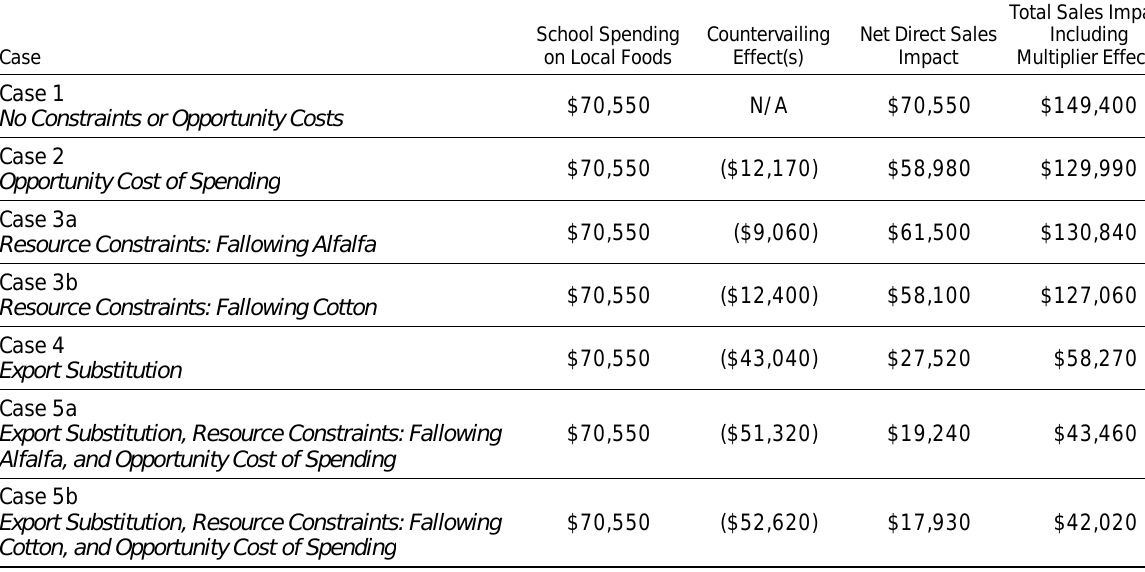
Table 6. Summary of Sales Impacts by Case Scenario (all in US$)